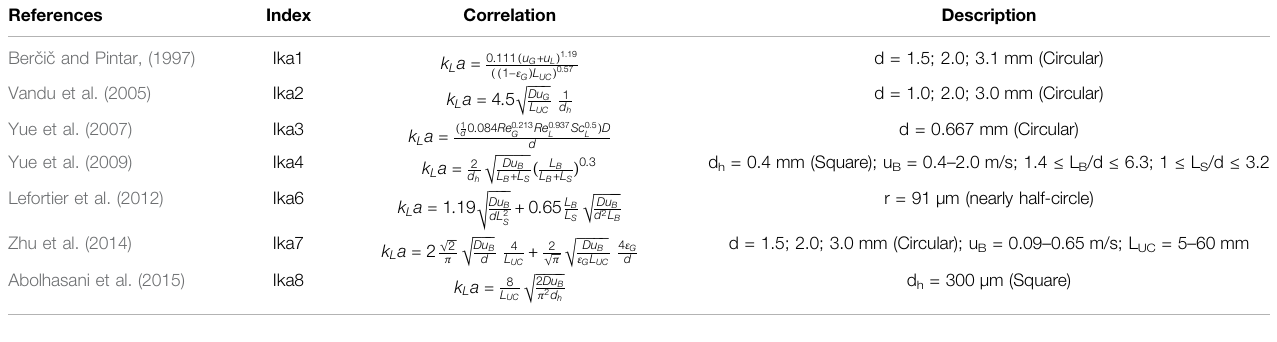
TABLE 2 | List of liquid volumetric mass transfer coef fi cients for Taylor fl ow regime in a microreactor.